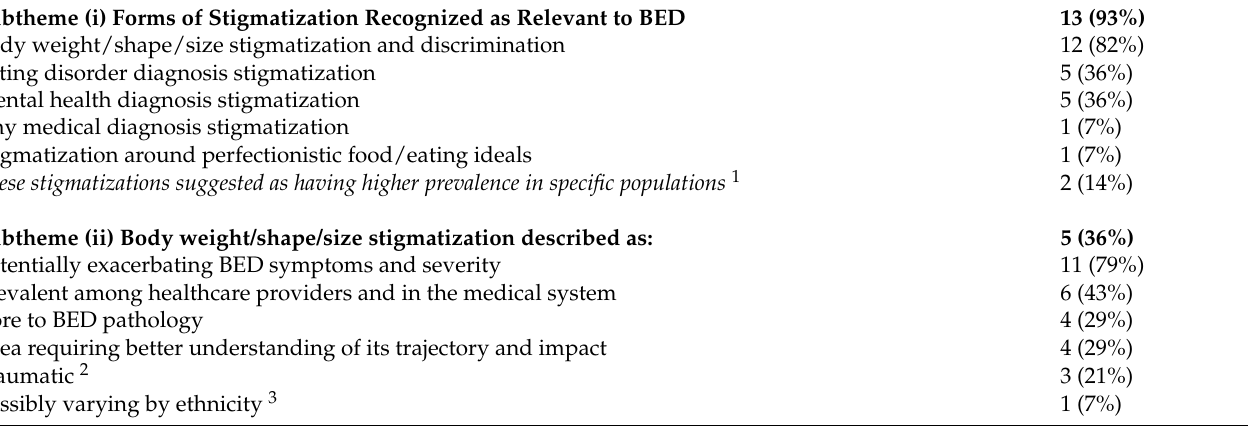
Table 7. Participant statements consistent with Theme 4, “stigmatization and its